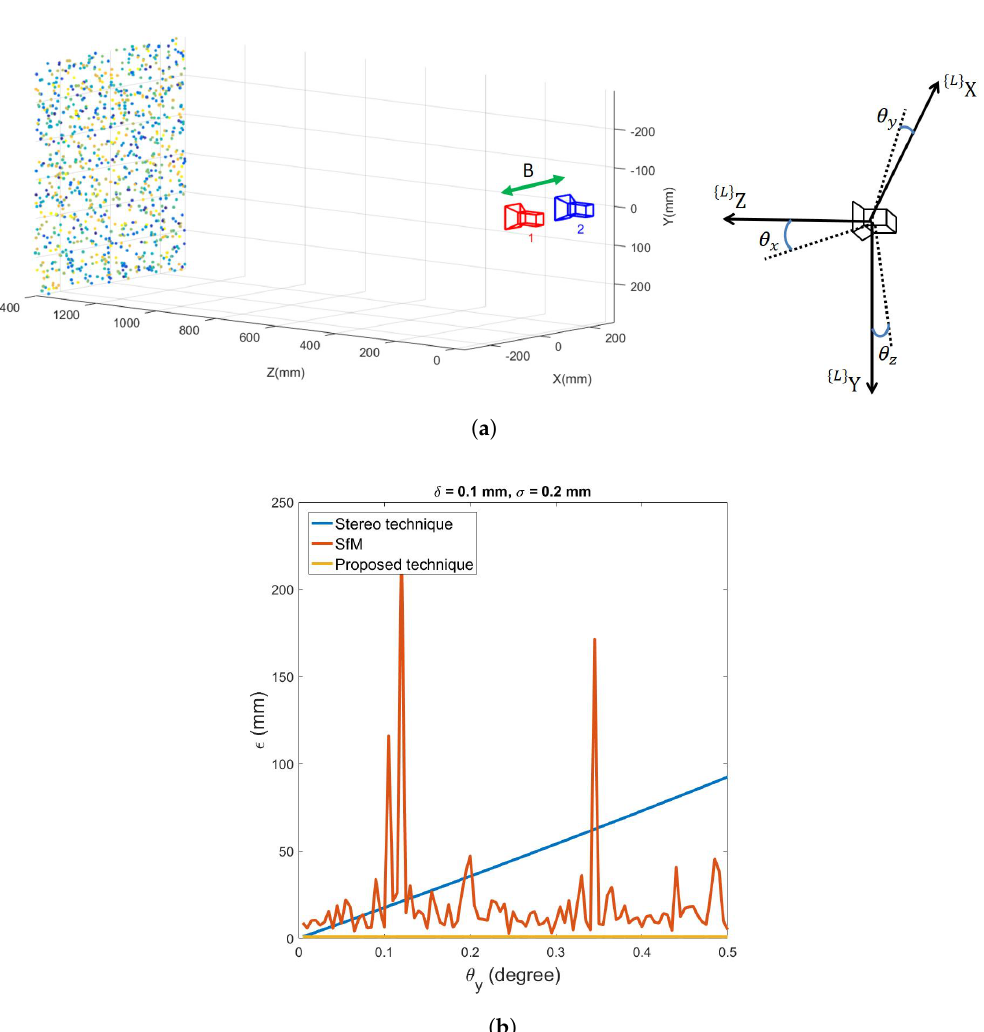
Figure 12. Comparison between stereo vision technique, traditional SfM, and the proposed technique under the influence of a changing θ y which is caused by the vibration. ( a ) Simulation environment for stereo vision-based technique. B is the baseline between the stereo cameras. ( b ) Reconstruction error for stereo technique, traditional SfM, and the proposed technique under vibration which causes changes to θ y